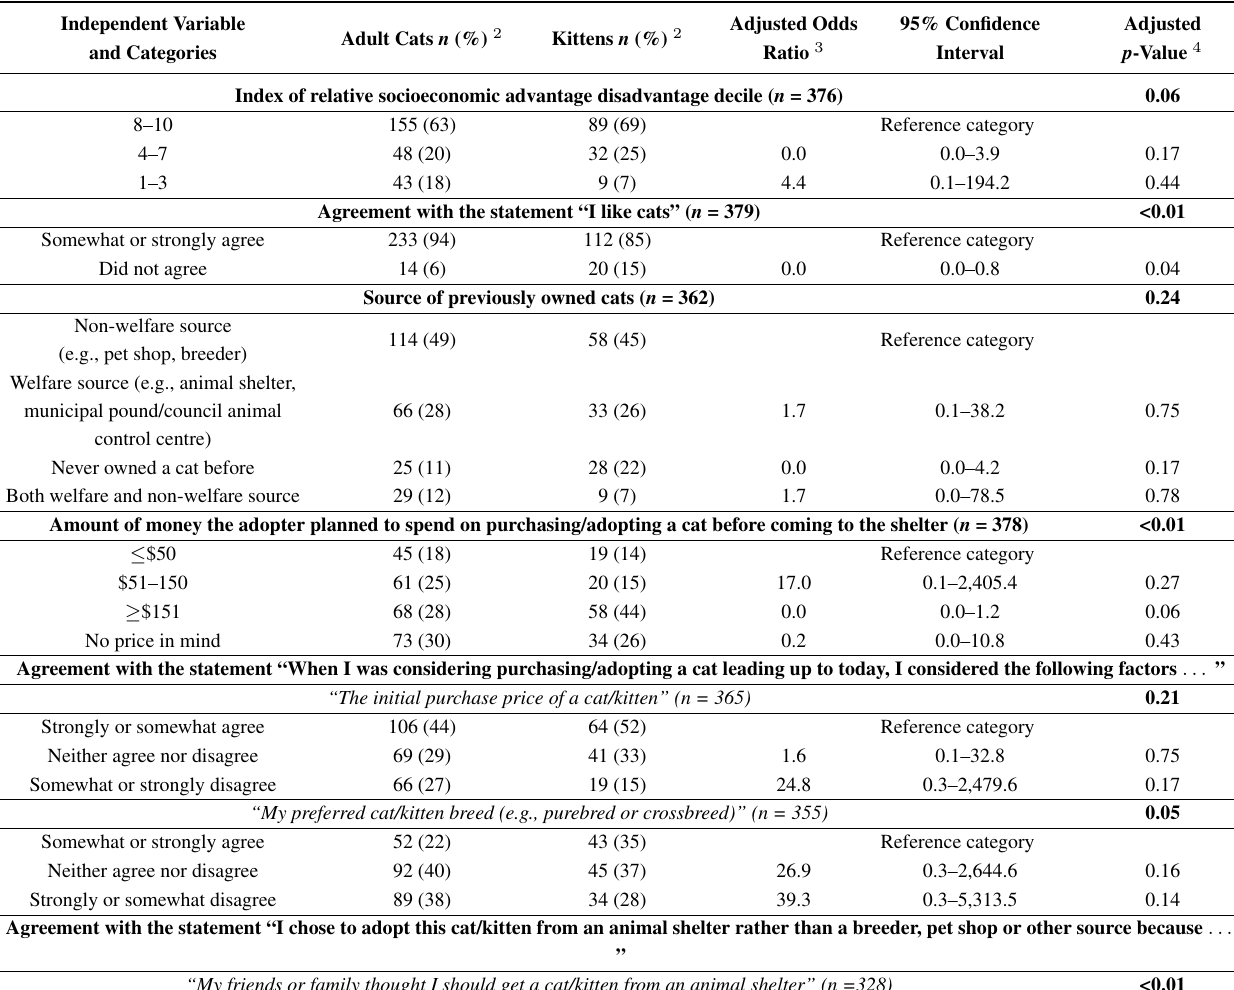
Table 1. Distributions of cats by cat age group (adult cat or kitten) and associations between potential determinants of cat age group adopted for 389 cats adopted from an animal shelter in Australia in 2013 1